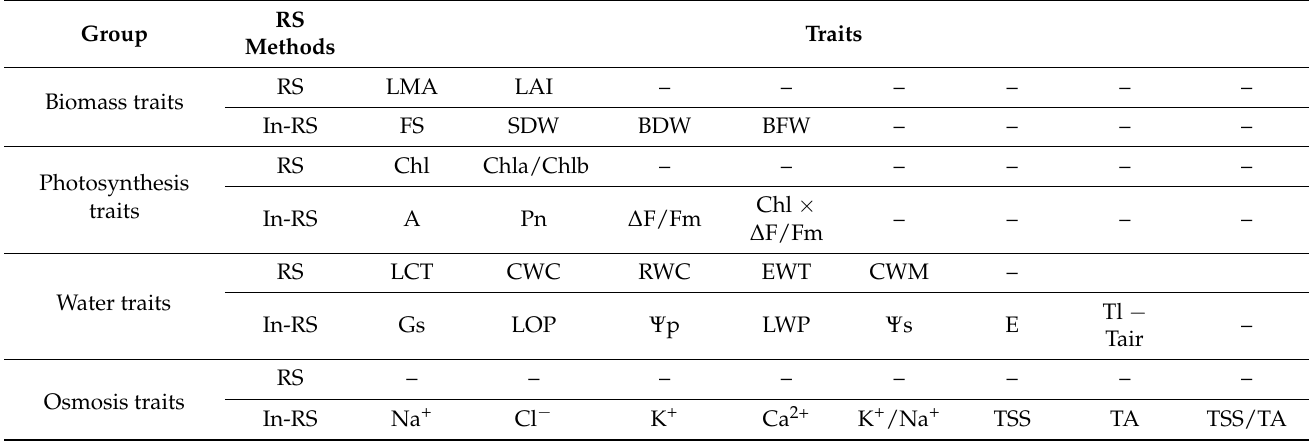
Table 1. Classification of plant traits included in this study.